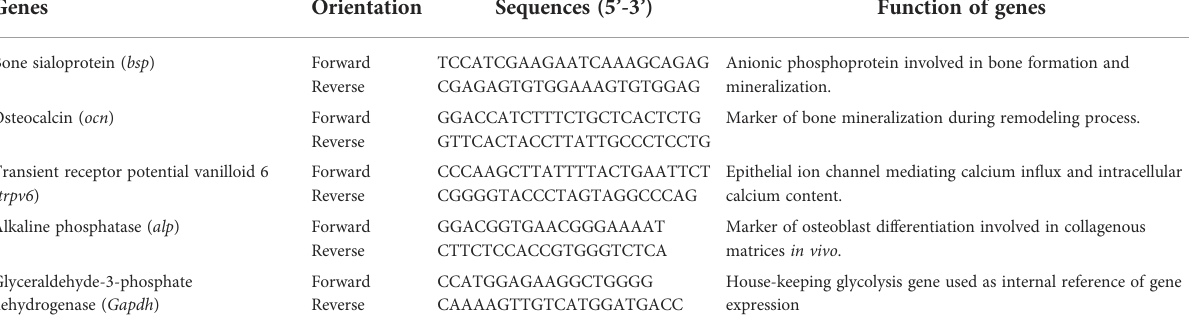
TABLE 1 The primer sequence of target